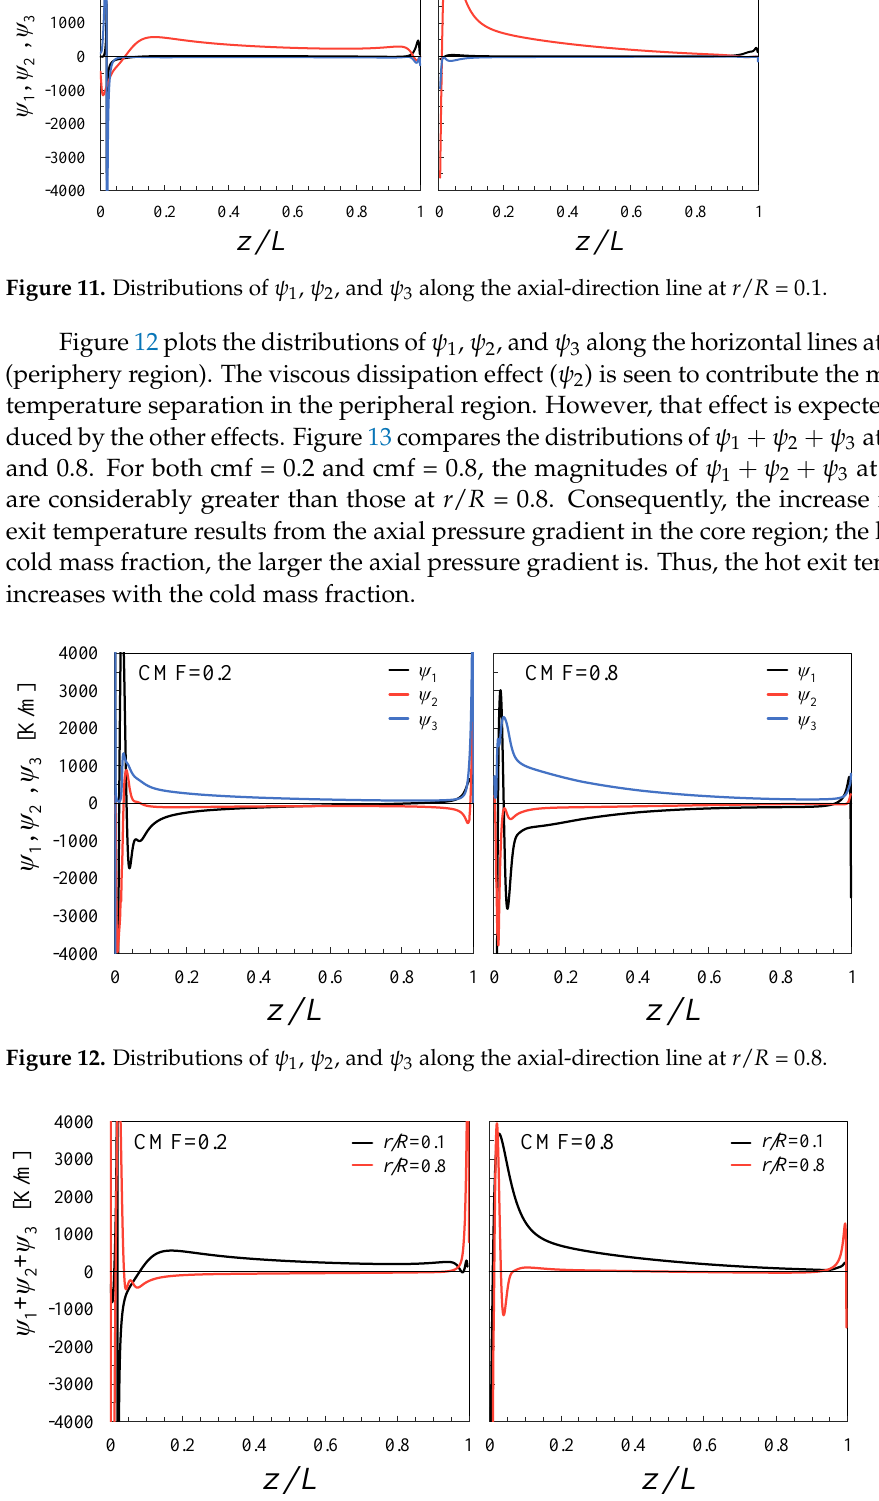
Figure 13. Comparison of the distributions of ψ 1 + ψ 2 + ψ 3 at r / R = 0.1 and 0.8.